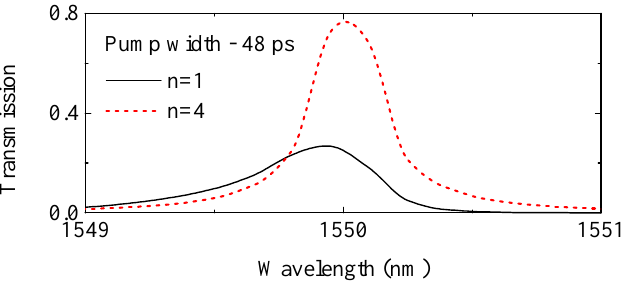
Figure 5. Transmission spectrum at the output core for the first and fourth order super-Gaussian pump pulses, with FWHM of 48 ps, at the fiber length with maximum power transfer for the output